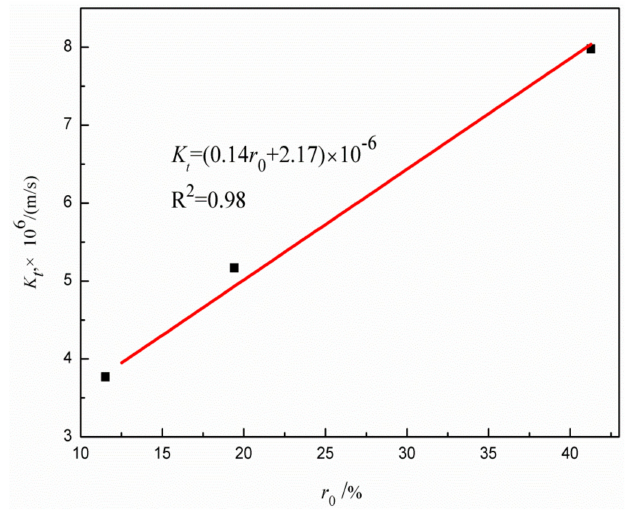
Figure 11. The relationship between the values of k t and r 0